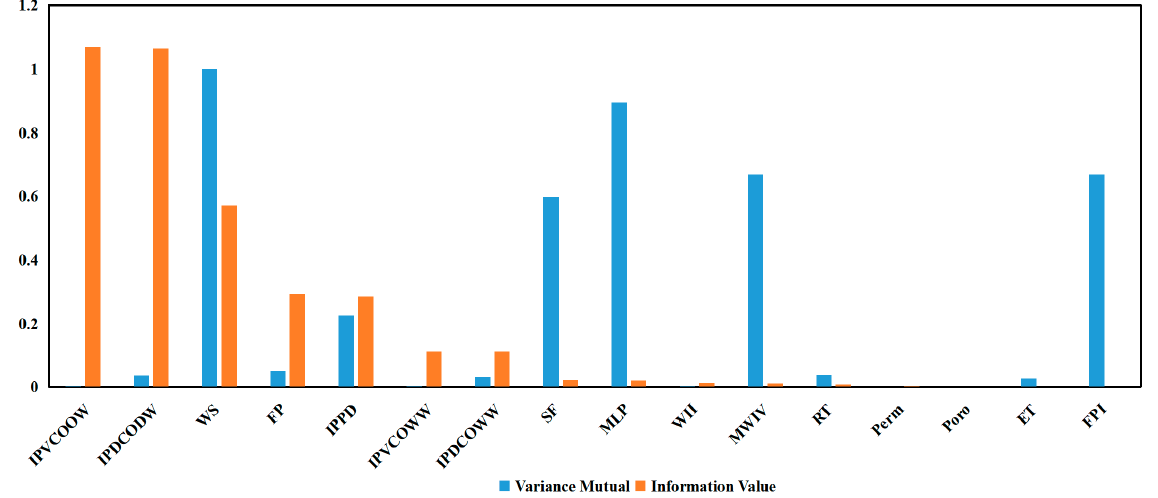
Figure 4. Variance and mutual information values of dataset D.